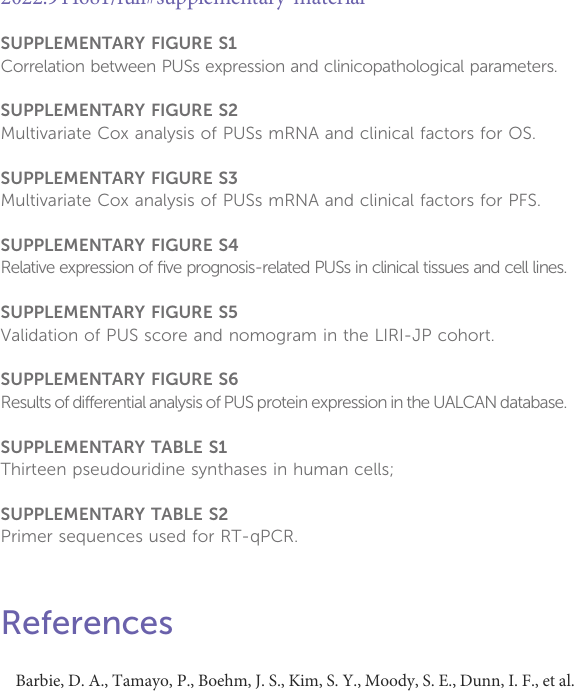
SUPPLEMENTARY TABLE S3 Results of differential expression analysis of PUS mRNA. SUPPLEMENTARY TABLE S4 Patients involved in multivariate Cox analysis. SUPPLEMENTARY TABLE S5 TP53 mutation status of HCC samples. SUPPLEMENTARY TABLE S6 TMB data of HCC patients. SUPPLEMENTARY TABLE S7 GSVA scores of the KEGG pathways in HCC samples. SUPPLEMENTARY TABLE S8 Univariate Cox analysis of KEGG pathways for OS.